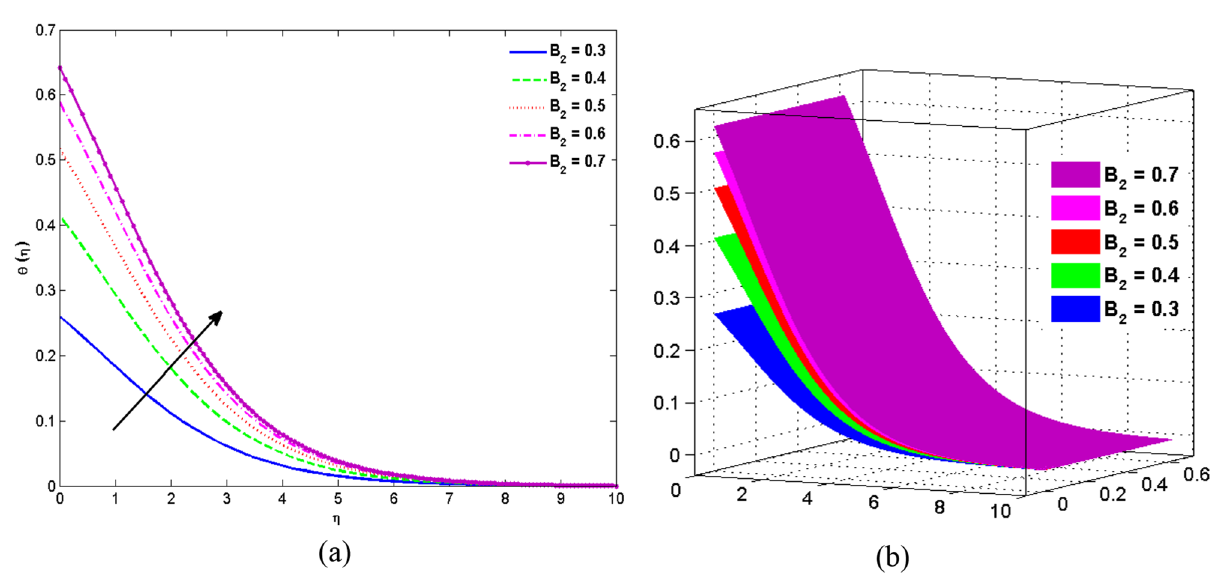
Figure 8. Variations of B 2 to θ(η)